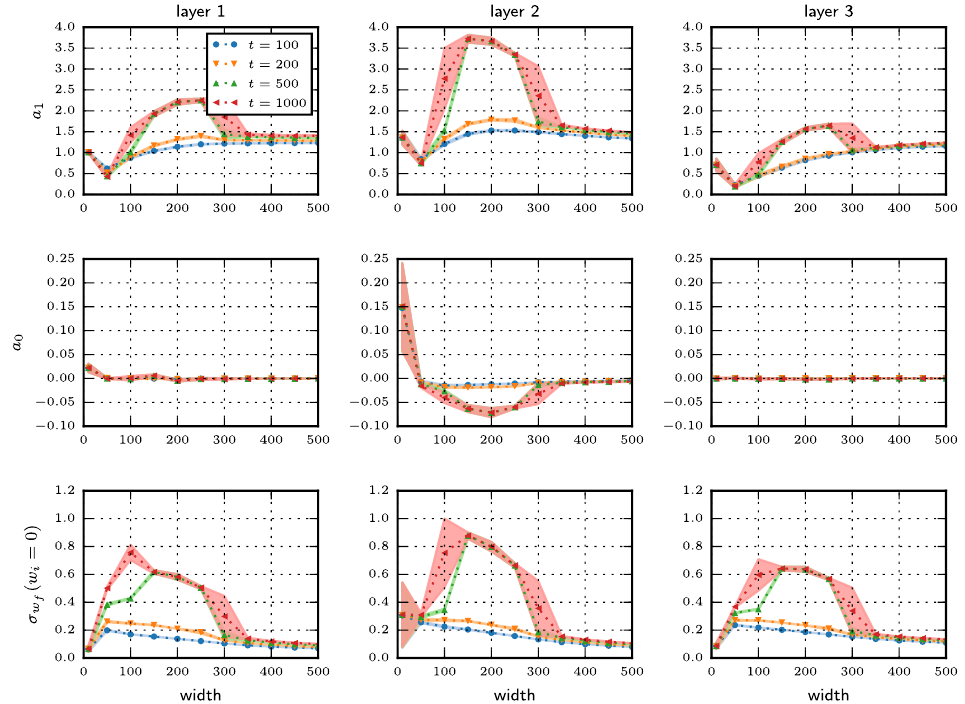
Figure A2. Mean and standard deviation of the trained weights in the networks of Figure 4. Top and middle rows: results of fitting a straight line a 0 + a 1 w i to the mean of the trained weights w f ( wi ) . Bottom row: standard deviation of the distribution of trained weights for the set of weights that are initialized with the value w i = 0. These results are averages measured in ten independent realizations, and the shaded areas represents the dispersion (standard deviation across